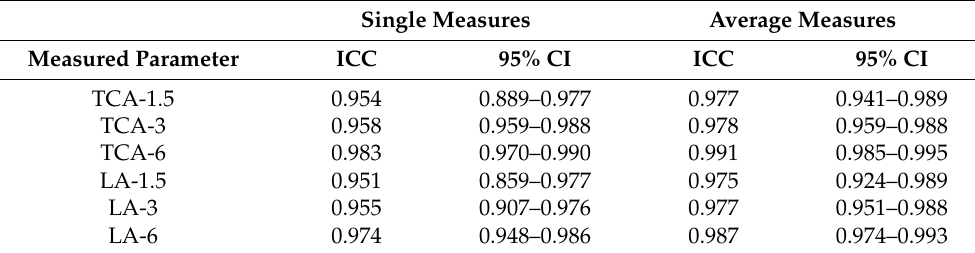
Table 3. Intra-rater reliability for measured choroidal parameters. Single Measures